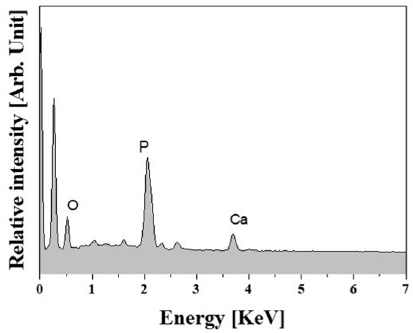
Figure 11. Representative EDS spectrum of the macro/micro-porous PCL/HA composite scaffold produced with a HA content of 20 wt % after soaking in an SBF solution for 3 days.